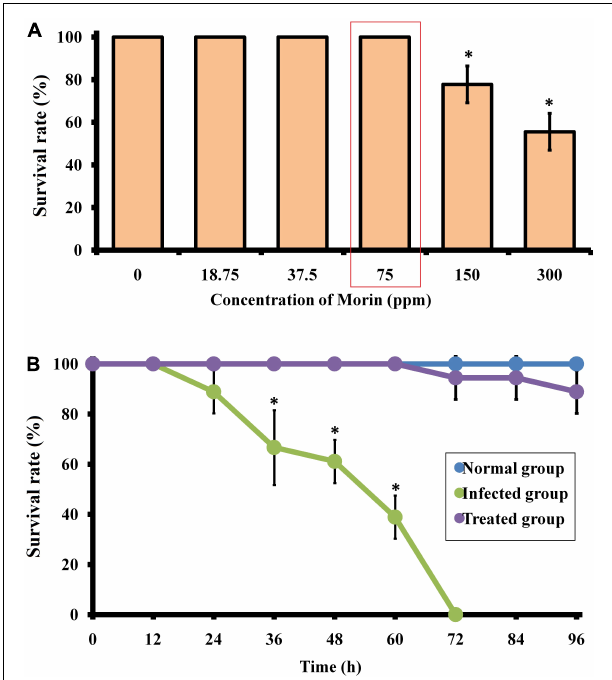
FIGURE 9 | (A) Surival percentage of zebrafish in the presence of morin at different concentrations. (B) Survival percentage of C. albicans -infected zebrafish upon morin treatment (75 µ g/ml) up to 96 h. Data are presented as means ± SD. *Indicates statistical significance ( p <